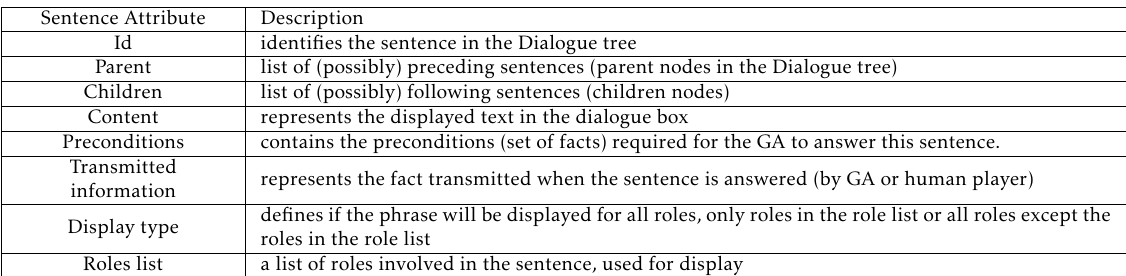
Table 2. Structure of a